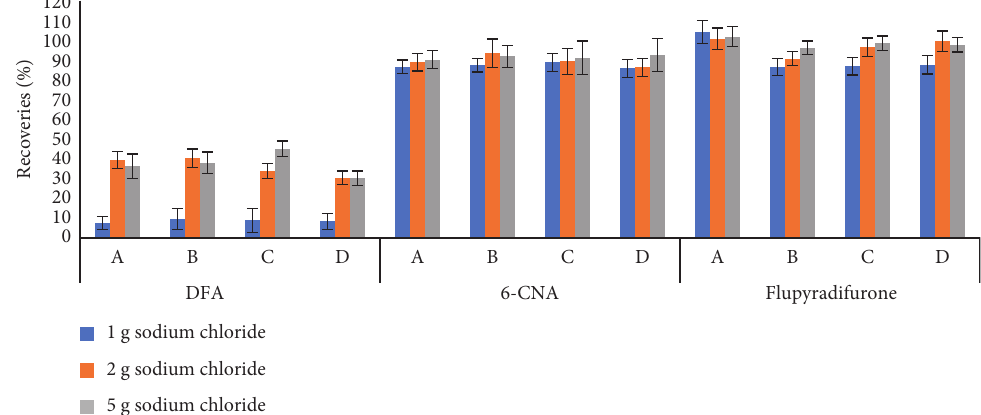
Figure 3: Recovery of flupyradifurone, DFA, and 6-CNA for the improved method under different amounts of sodium chloride condition ( n � 3).